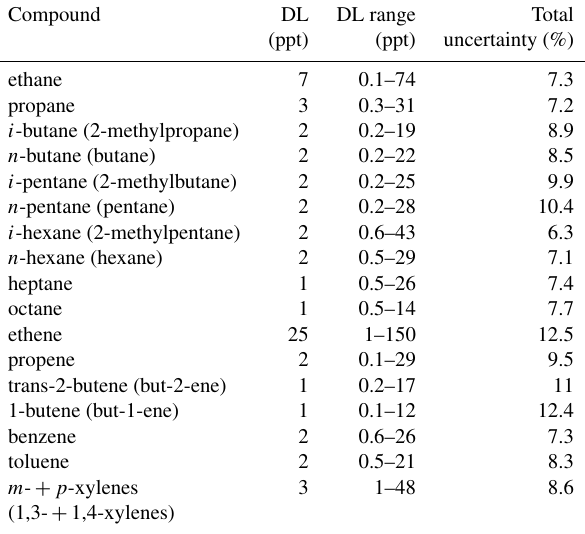
Table 1. Detection limits and total uncertainty of measured NMHCs. The average detection limits (DLs) for each compound are reported in the first column. DLs varied during the campaign as a result of different sampling volumes and wave height. The average total uncertainty was derived by error interpolation and is reported in the third